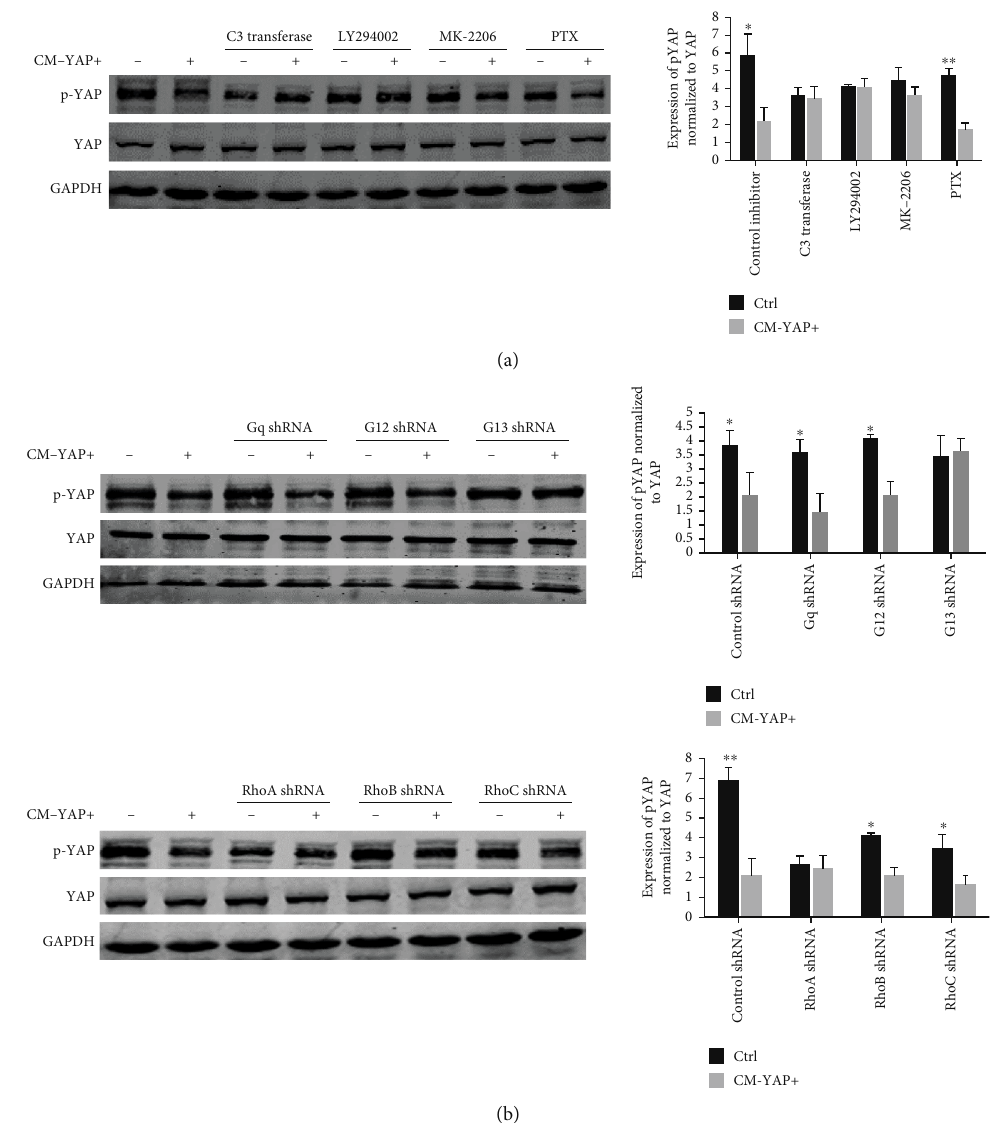
Figure 4: G -RhoA and PI3K/Akt involved in CM-YAP+ induced dpYAP in HUVECs. (a) After starved from FBS for 16hr, cells were 13 pretreated with di ff erent inhibitors, LY294002 (10 μ M, 1 hr), MK2203 (1 μ M, 1 hr), and C3 (1 μ g/mL, 2hr) prior to stimulation with CM-YAP+ (2 hr). pYAP and total YAP expression in HUVECs was analyzed by Western blot. ∗ p < 0 : 05 . ∗∗ p < 0 : 01 . (b) HUVECs were transfected with di ff erent shRNA for 48hr, starved and then, treated with CM-YAP+ (2 hr). Cell lysates were analyzed by Western blot. Representative results are shown. ∗ p < 0 : 05 . ∗∗ p < 0 : 01